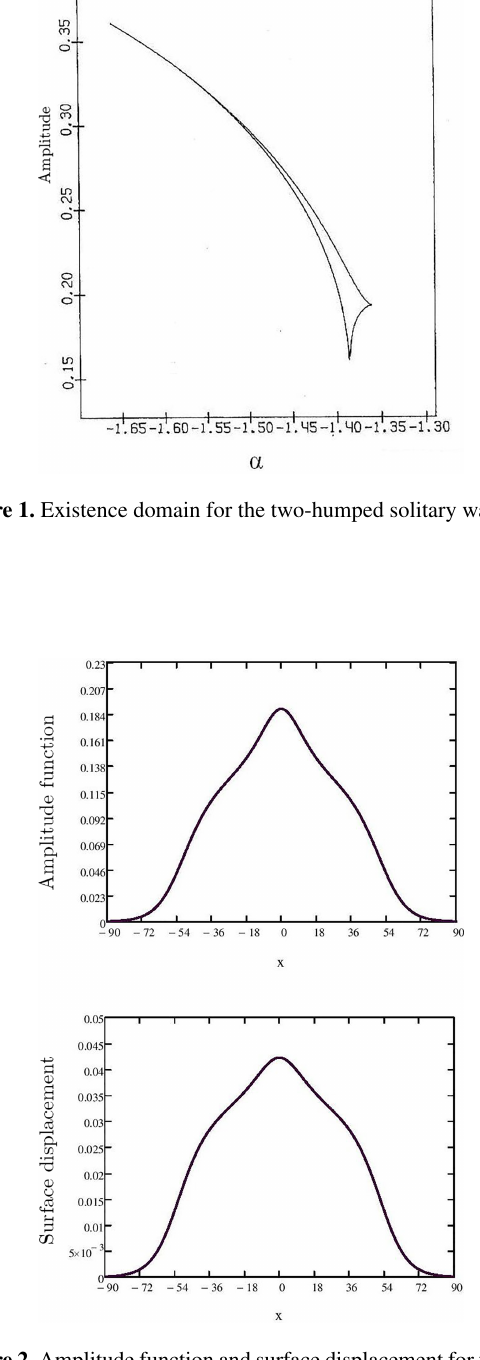
Figure 2. Amplitude function and surface displacement for the two- humped solitary wave; α = − 1 .